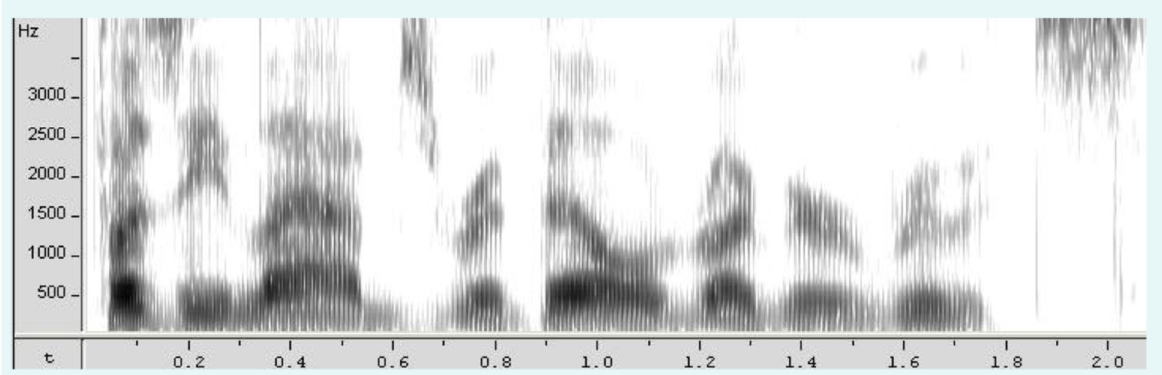
Fig. 2 Example of a wide-band speech spectrogram. Note the horizontal dark bands (formants), roughly spaced every 1 kHz; vertical axis is frequency in kHz; horizontal axis is time in